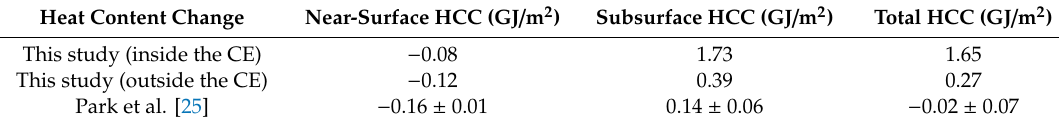
Figure 3. Comparison of Argo observed subsurface temperature responses to Typhoon Soudelor inside ( a ) and outside ( b ) the CE region. ( c ) Negative SSHA before the typhoon (on 5 August). ( d ) Negative SSHA after the typhoon (on 10 August). Symbols “a” and “b” denote the locations of Argo floats inside and outside the CE region, with “1” and “2” representing the locations before and after the passage of Typhoon Soudelor, respectively. The red triangles denote the center locations of typhoon at 00:00 UTC on 6 and 7 August, respectively. Table 1. Comparison of Argo observed heat content change with previous study.